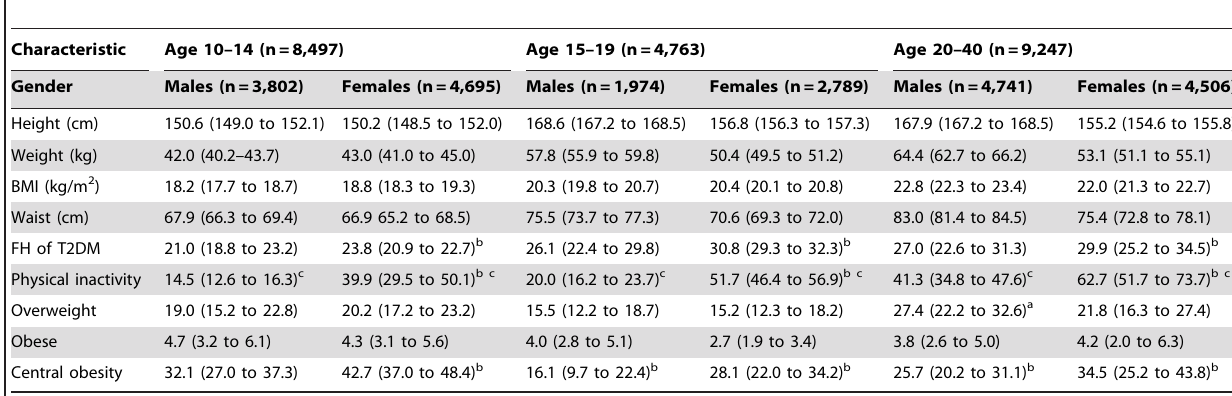
Table 1. Demographic and anthropometric characteristics of 22,507 subjects representative of the urban population of Colombo District aged between 10–40 years.